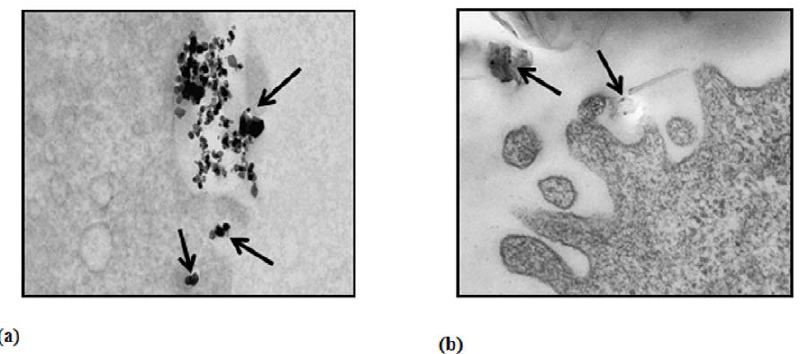
Figure 2. Transmission Electron Microscopy (TEM) analysis of internalization of TiO 2 -NPs in A549 cells. TEM microphotographs showing internalization of TiO 2 -NPs (a, b) in human lung cancer cells-A549. Arrows indicates the nanoparticles were adhered on the cell surface between microvilli and pseudopodes within few minutes of time (a) and subsequently internalized in small vacuoles deep in the cytoplasm, when observed at 24 h